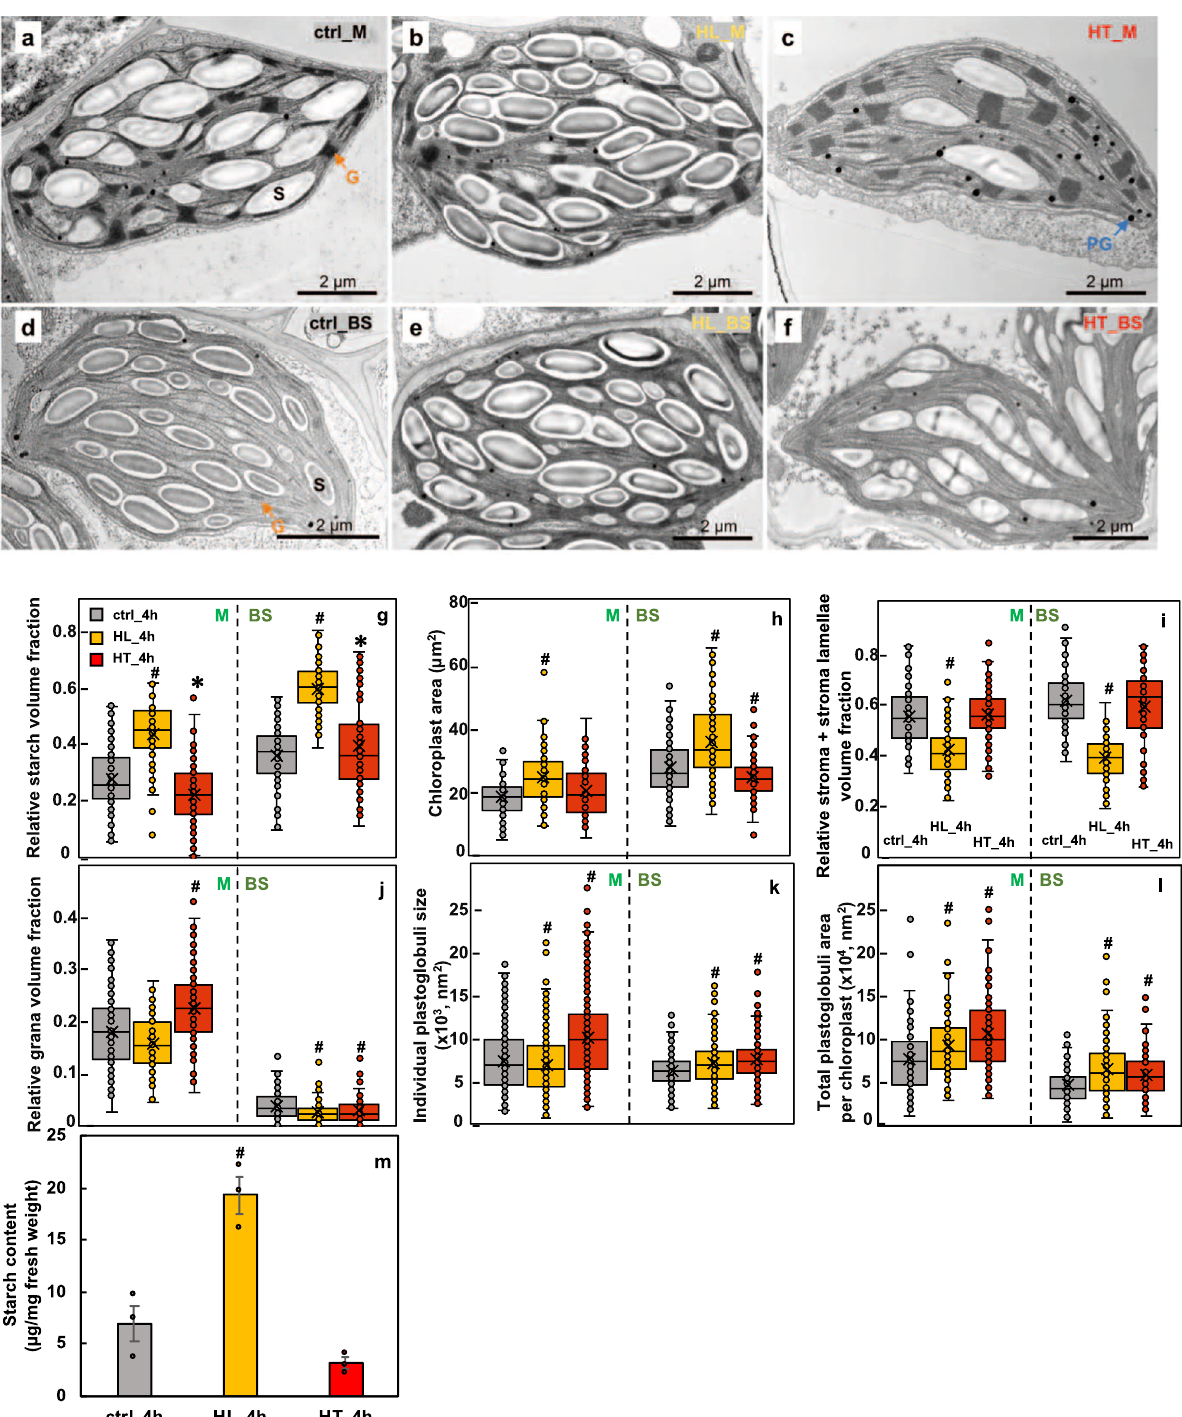
Fig. 7 High light increased starch accumulation and both high light and high temperature treatments induced chloroplast plastoglobuli formation in S. viridis leaves. a – f Representative transmission electron microscopy (TEM) images of mesophyll (M) and bundle sheath (BS) chloroplasts in leaves of S. viridis after 4 h treatments of control (ctrl_4h) or high light (HL_4h) or high temperature (HT_4h). TEM images of mesophyll (a – c) and bundle sheath (d – f) chloroplasts. S labels the starch granule; G labels grana, the orange arrows indicate grana in mesophyll and bundle sheath chloroplasts; PG labels plastoglobuli. g , i , j Relative volume fraction of indicated parameters were quanti fi ed using Stereo Analyzer with Kolmogorov – Smirnov test for statistical analysis compared to the same cell type of the control condition. h , k , l Area and size of indicated parameters were quanti fi ed using ImageJ with two-tailed t - test with unequal variance compared to the same cell type of the control condition. Each treatment had three biological replicates, total 90 – 120 images per treatment. * 0.05< p < 0.01; # p < 0.01. m Starch quanti fi cation using starch assay kits. Values are mean ±SE, n = 3 biological replicates. Pound symbols indicate statistically signi fi cant differences as compared to ctrl_4h using Student ’ s two-tailed t -test with unequal variance ( # p <